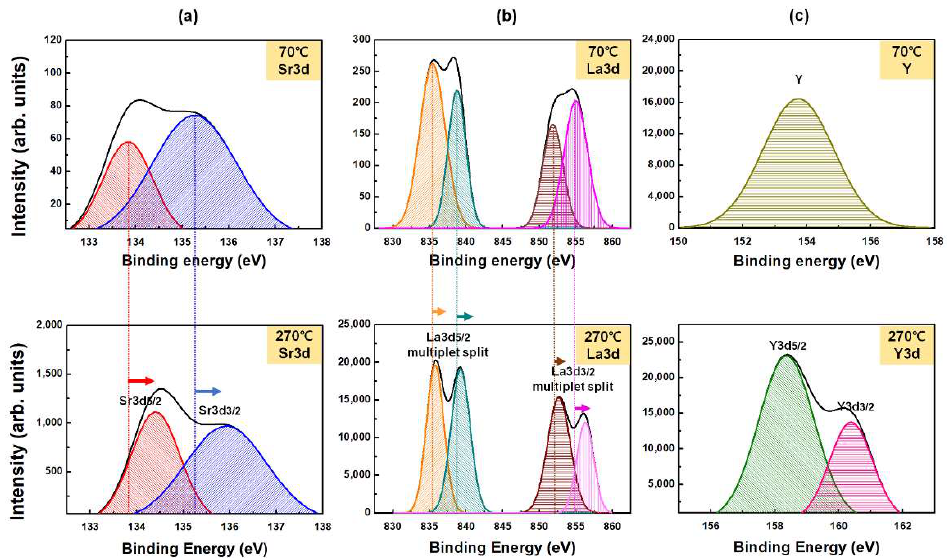
Figure 3. ( a ) Sr 3d, ( b ) La 3d, and ( c ) Y 3d core-level XPS spectra of the brush-coated LaYSrO films cured at 70 and 270